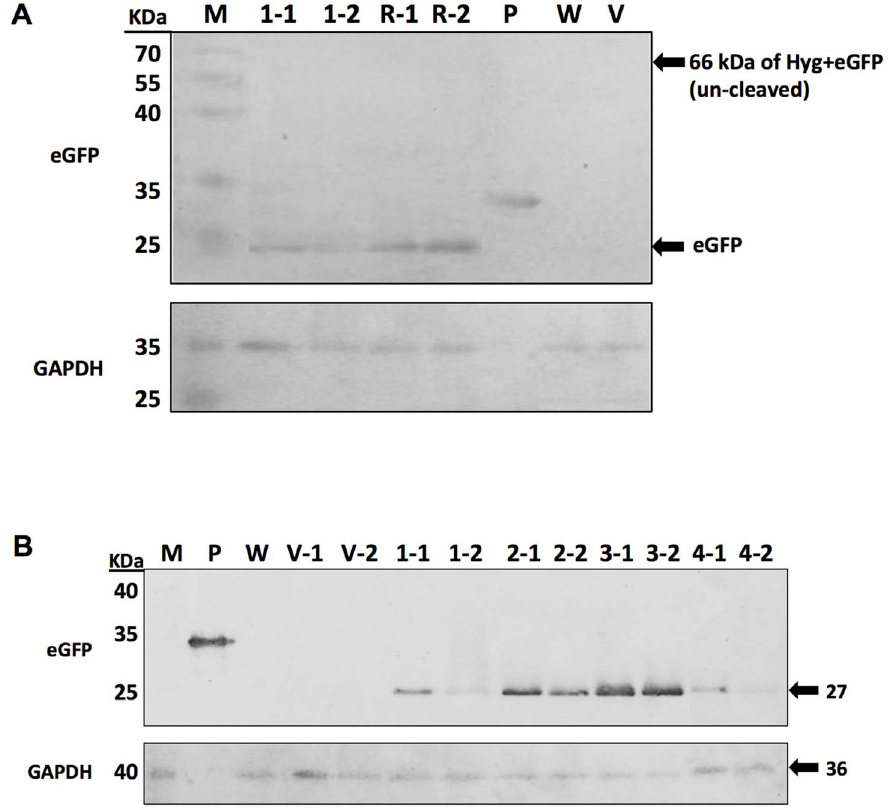
Figure 3. Expression of EGFP in F.velutipes transformants. (A) Western blot analysis of EGFP protein expression with the various gene positions in the F. velutipes transformants AiH-P2AG and AiG-P2AH. (B) Western blot analysis of EGFP protein expression with the various copy numbers in the indicated F. velutipes transformants. Lane P: positive control, a commercial EGFP containing tags at both the N and C terminus (293 amino acids, 32.7 kDa), the EGFP expressed in transformants is 266 amino acids, 27 kDa; lane W: wild type; lane V-1, V-2: F. velutipes AiH transformant vector control; lane 1–1, 1–2: F. velutipes AiH-P2AG transformants; lane 2–1, 2–4: F. velutipes AiH-P2AGx2 transformant; lane 3–1, 3–2: F. velutipes AiH- P2AGx3 transformants; lane 4–1, 4–2: F. velutipes AiH-P2AGx4 transformants; and lane M: